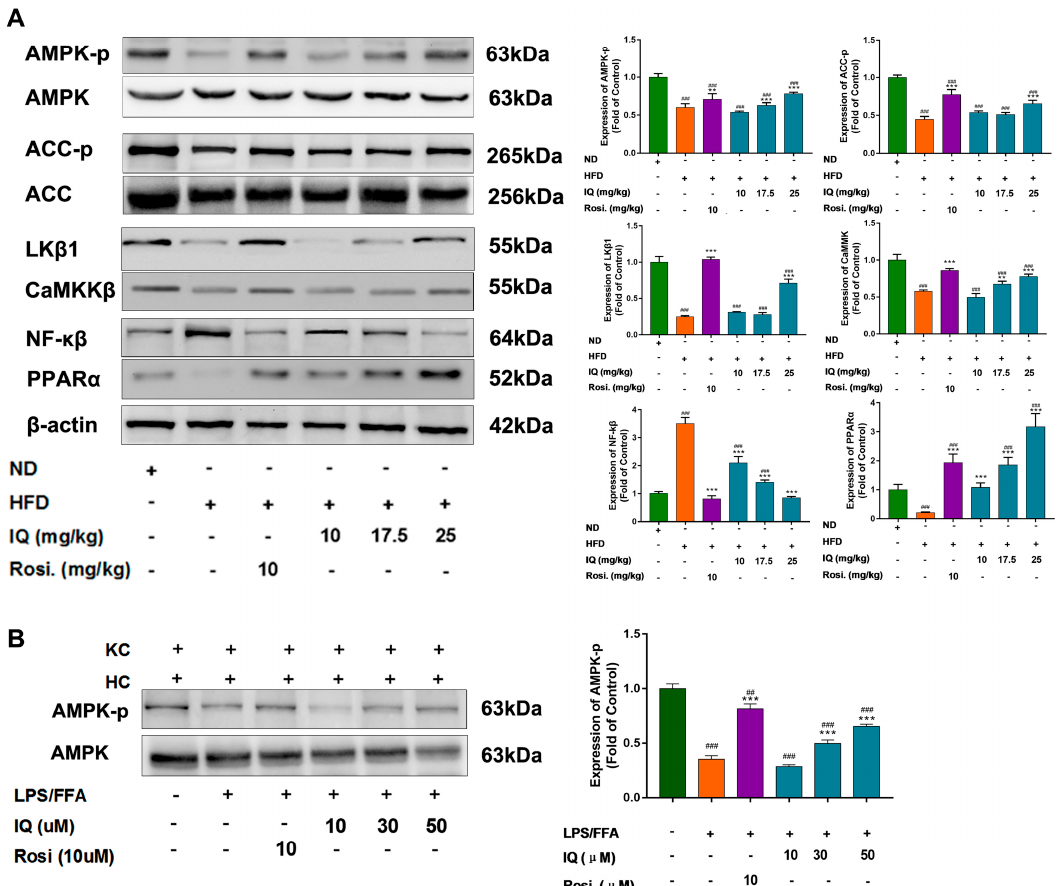
Figure 3. IQ enhances the AMP-activated protein kinase (AMPK) phosphorylation via Liver kinase β 1 (LK β 1) upstream. ( A ) Western blot analysis of AMPK, phospho-AMPK (p-AMPK), Acetyl-CoA carboxylase (ACC), phospho-ACC (p-ACC), Liver kinase β 1 (LK β 1), Calcium/calmodulin-dependent protein kinase kinase-1 (CaMKK1), Nuclear factor- κ B (NF- κ B), and Peroxisome proliferator-activated receptor alpha (PPAR- α ); ( B ) representative blot for AMPK, p-AMPK in lipopolysaccharides/free fatty acids (LPS/FFA) induced in vitro co-culture model. ## p < 0.01, ### p < 0.001 represent compared with control. ** p < 0.01, *** p < 0.001 represent compared with model. The significant statistical difference